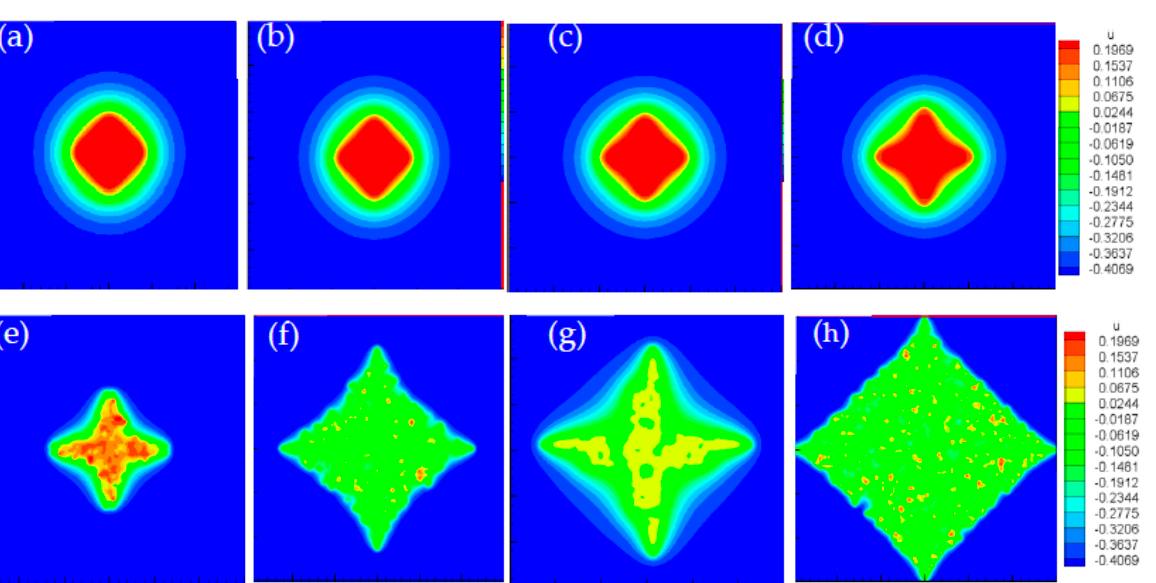
Δ Figure 7. = − 0.45, t = 30000 Δ t, ( a ) γ = 0.03; ( b ) γ = 0.04; ( c ) γ = 0.05; ( d ) γ = 0.06; 9000 Δ t, ( e ) γ = 0.07; ( f ) γ = 0.08; ( g ) γ = 0.09; ( h ) γ = 0.1. Crystal temperature field